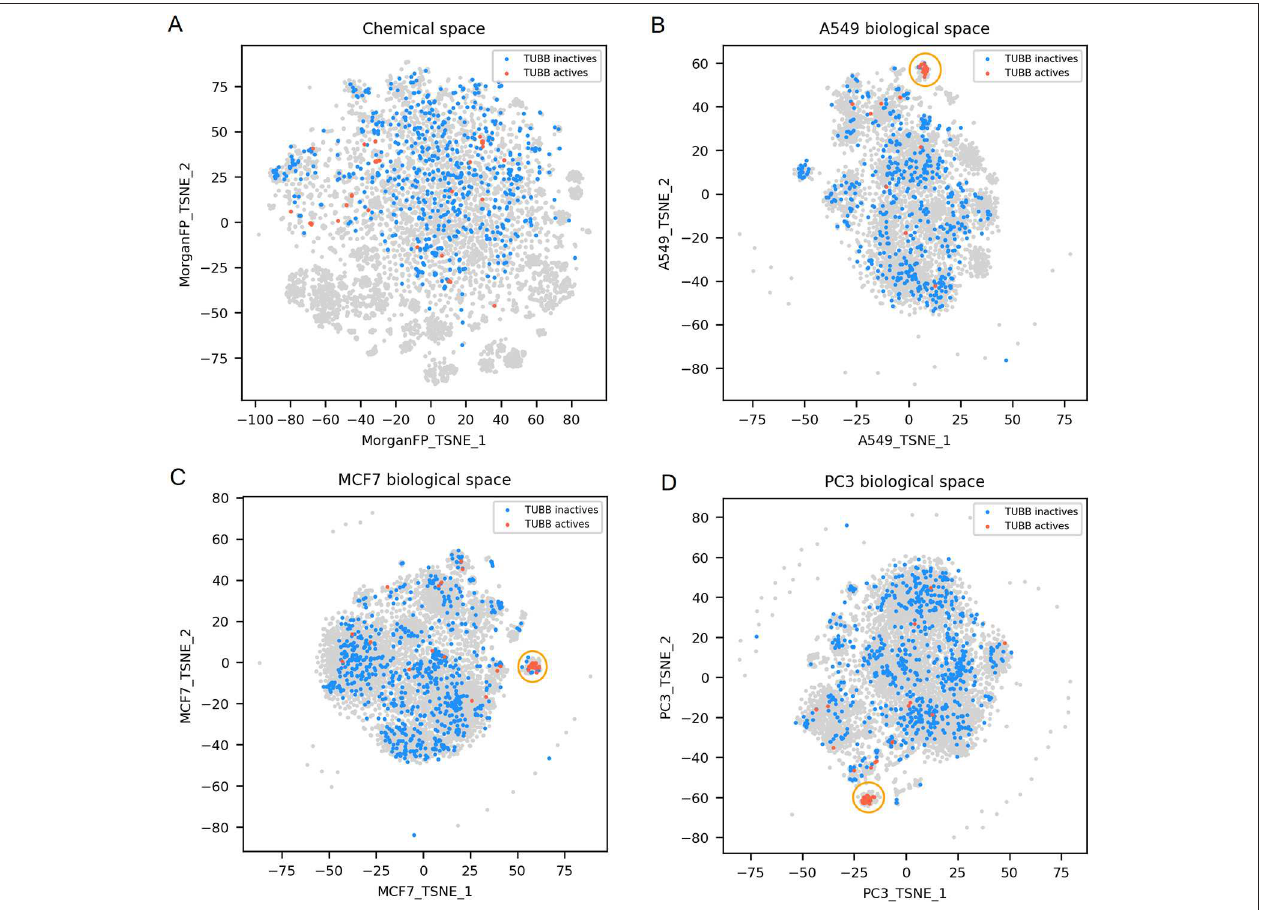
FIGURE 4 | TUBB active and inactives compounds in the chemical space and the different biological spaces formed by GES produced in a single cell line. (A) Chemical space; (B) A549 biological space; (C) MCF7 biological space; (D) PC3 biological space. Points corresponding to TUBB actives ( n inactives ( n 697) are blue, gray points have no available label concerning TUBB activity. Orange circles point out clustering of active compounds. =